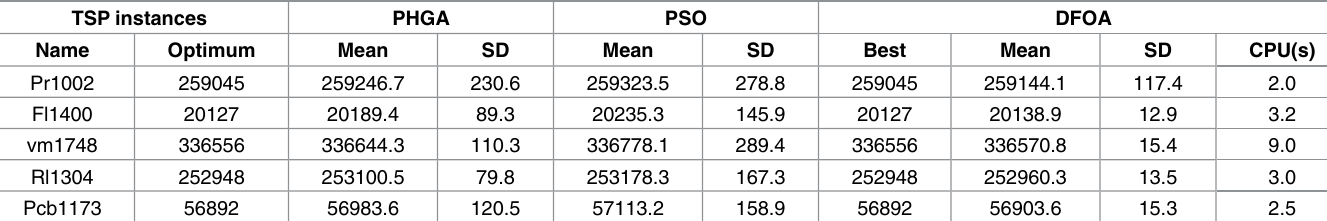
Table 2. Comparison of the DFOA, PHGA, and PSO on medium-scale TSP instances after 20 repetitions. TSP instances